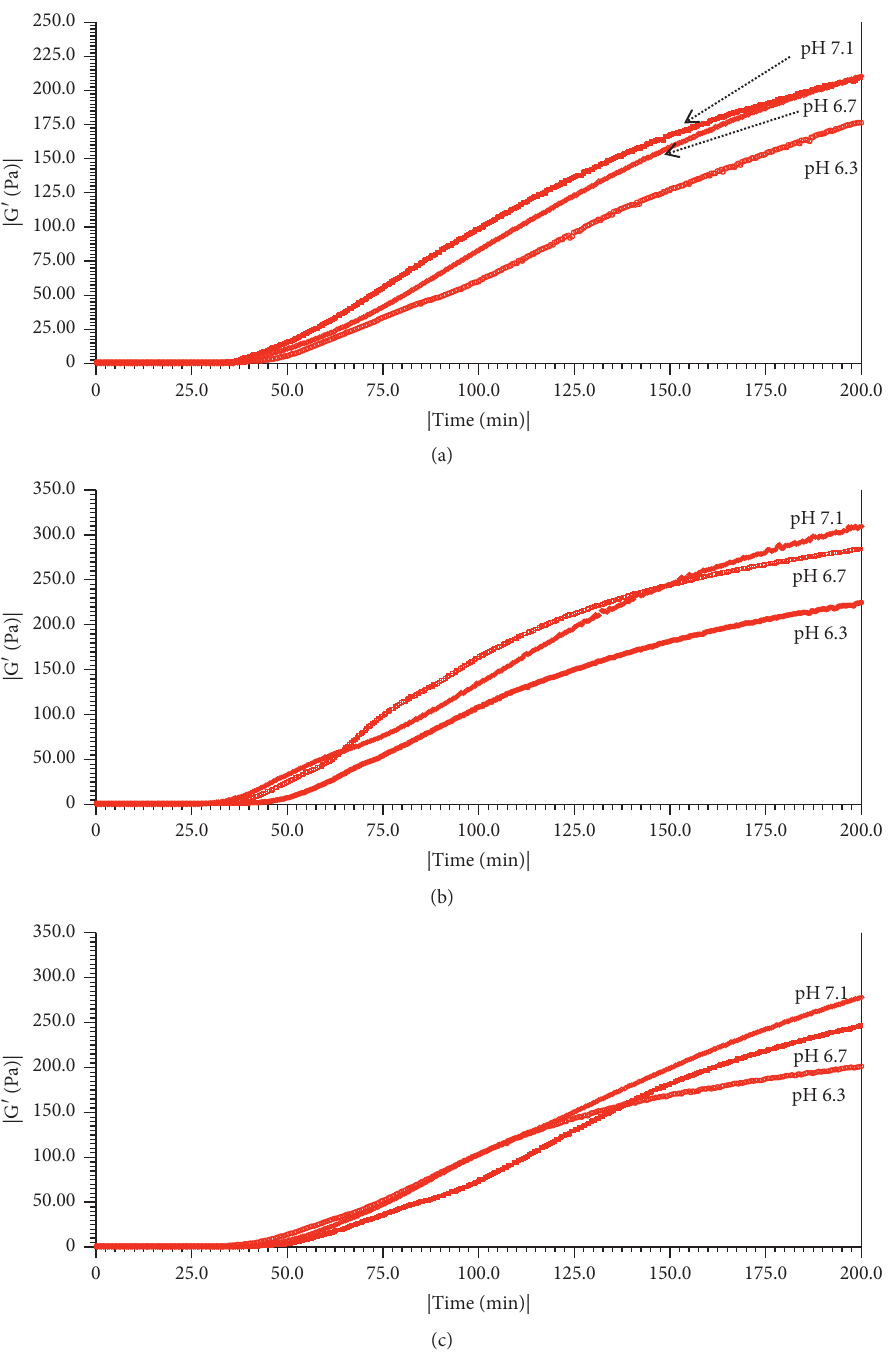
Figure 2: Effect of transglutaminase and preheating pH on the storage modulus of acid-induced gels prepared from 0 (a), 3 (b), and 10 (c) U transglutaminase per gram